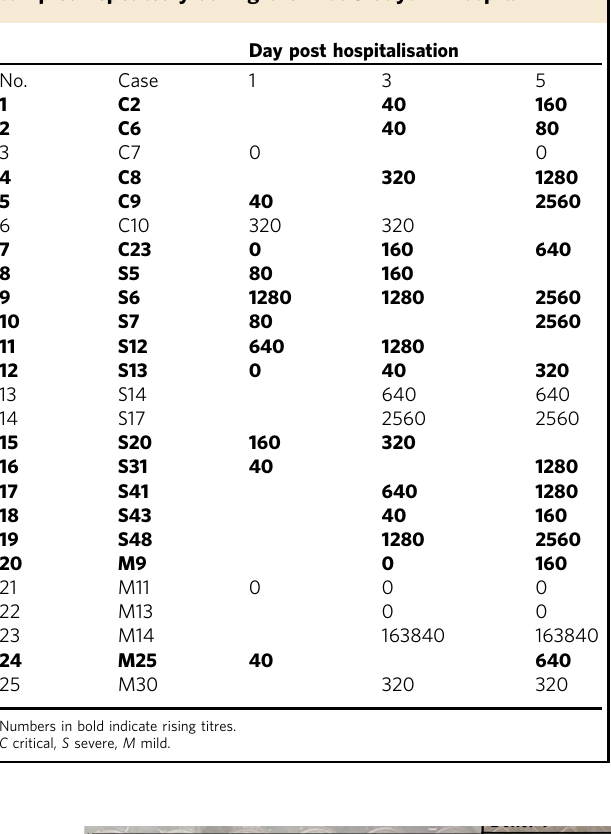
Table 1 Fifty-two samples from 24 donors who were sampled repeatedly during the fi rst 5 days in hospital.